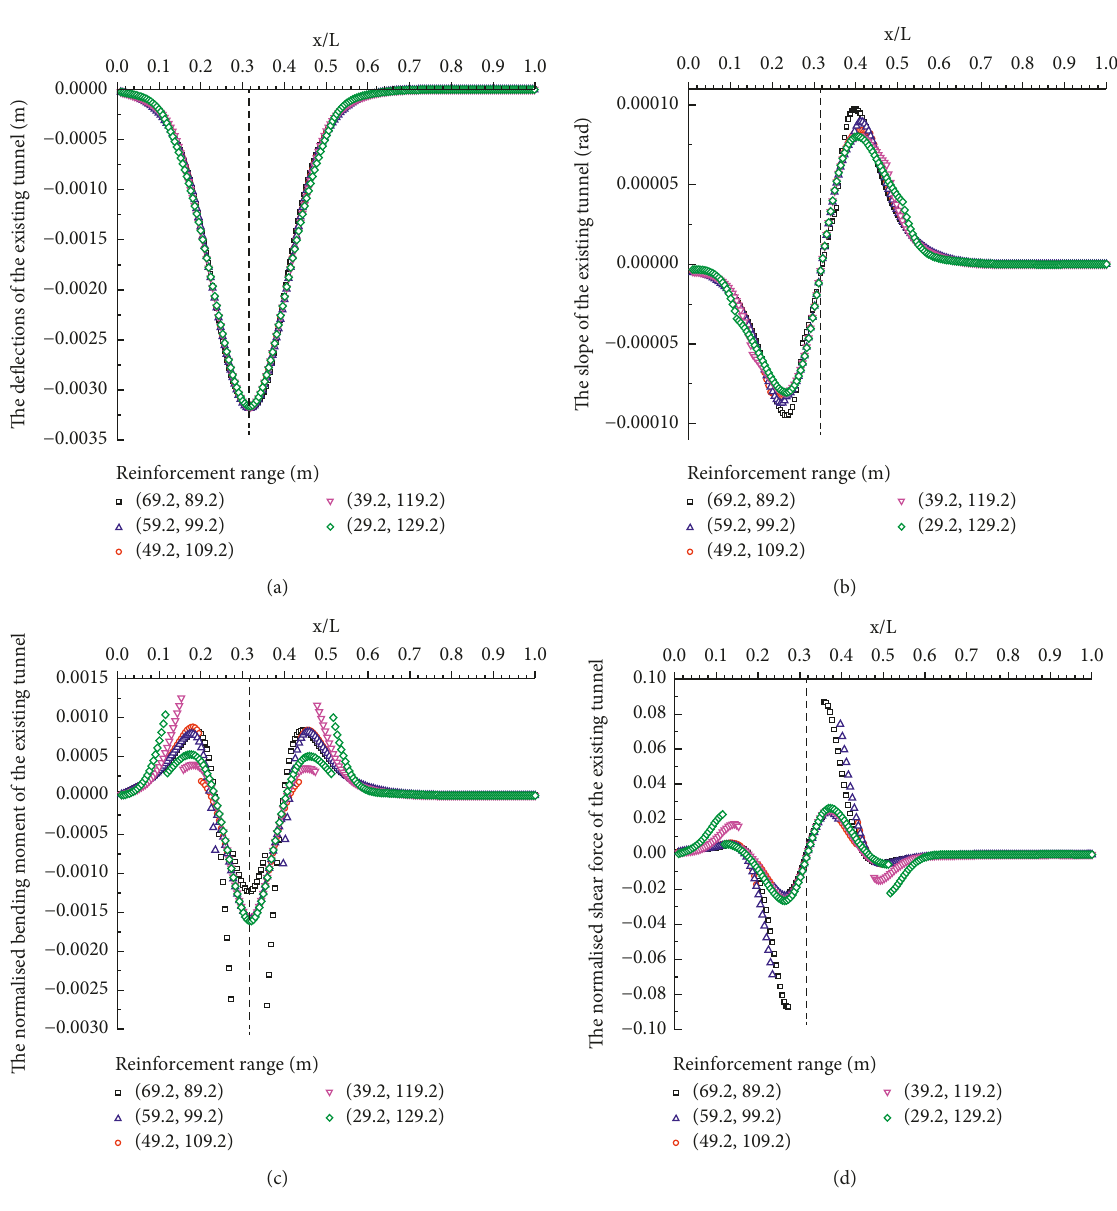
Figure 21: (a) The effects of different reinforcement ranges on the deflection of the existing tunnel. (b) The effects of different reinforcement ranges on the slope of the existing tunnel. (c) The effects of different reinforcement ranges on the normalized moment of the existing tunnel. (d) The effects of different reinforcement ranges on the normalized shear force of the existing